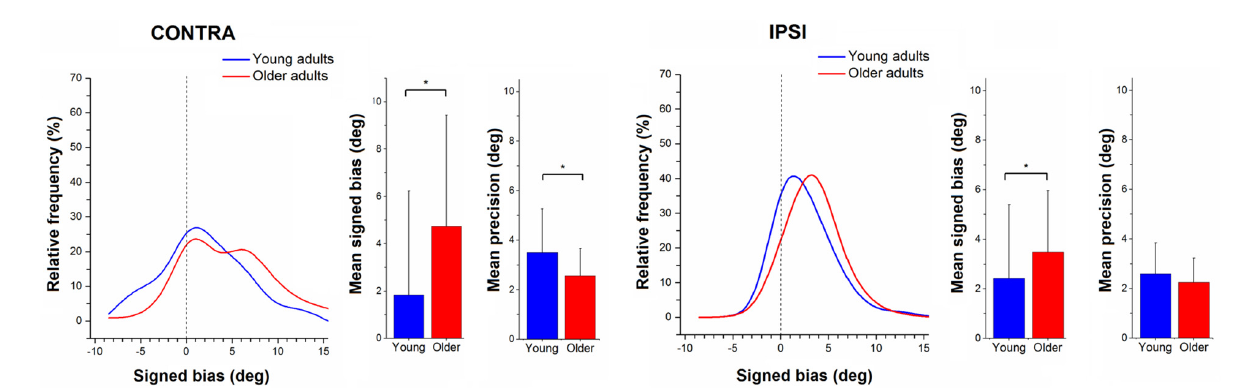
FIGURE 3 | Relative frequency distribution for signed bias. Mean and standard deviation histograms for signed bias and precision during active ipsilateral and contralateral wrist position sense matching. Relative frequency distribution of mean outcomes of proprioceptive signed bias in older (red) and young adults (blue), expressed in percentages. Note that the distribution for the older adults is shifted to the right, indicating a higher bias. Means and standard deviations of contra- and ipsilateral signed bias and precision (in degrees) are shown in the respective bar graphs, with a ∗ indicating a significant difference, p < 0.05.